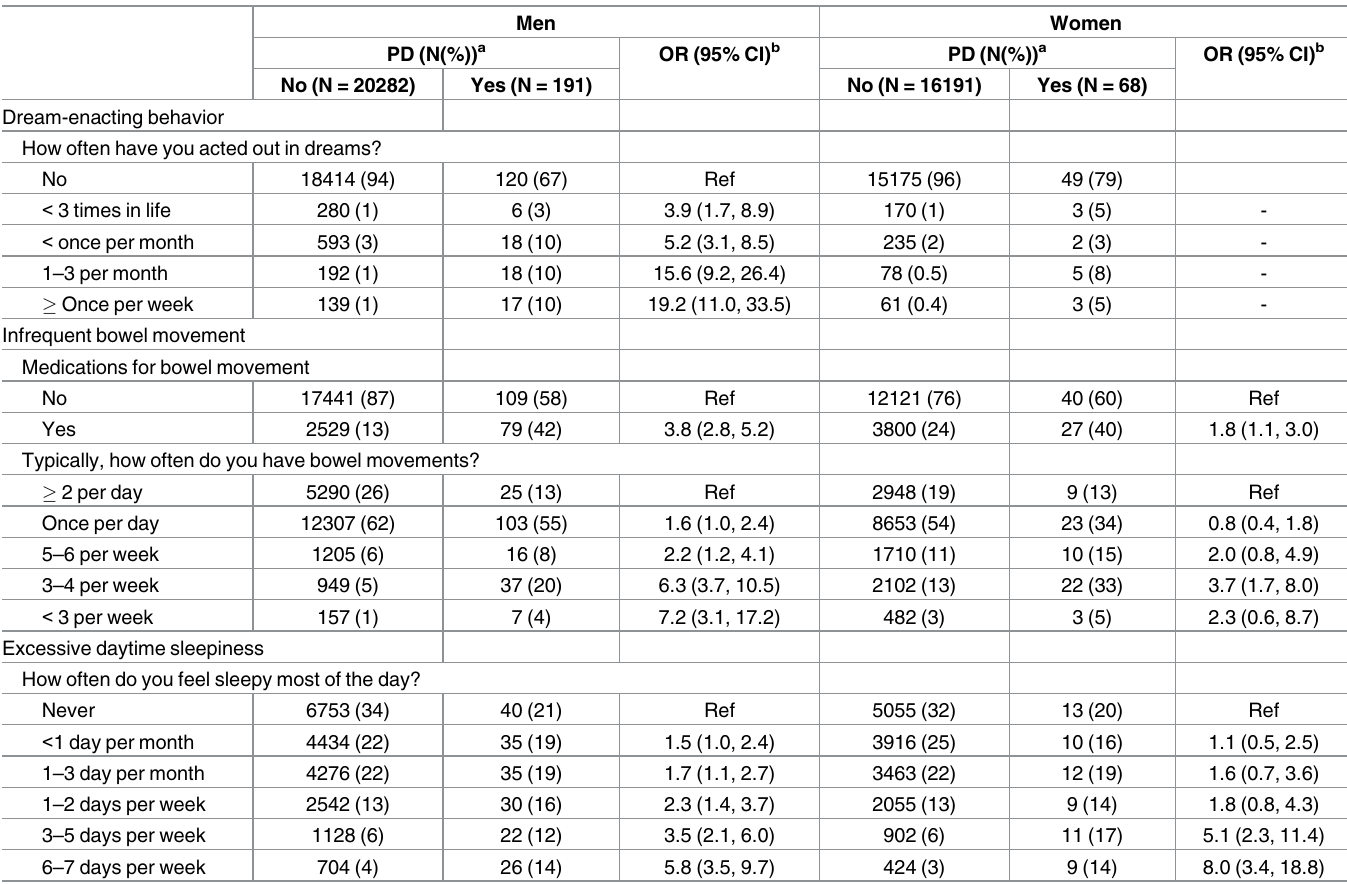
Table 4. Associations between frequency of individual non-motor symptoms and PD in the Agricultural Health